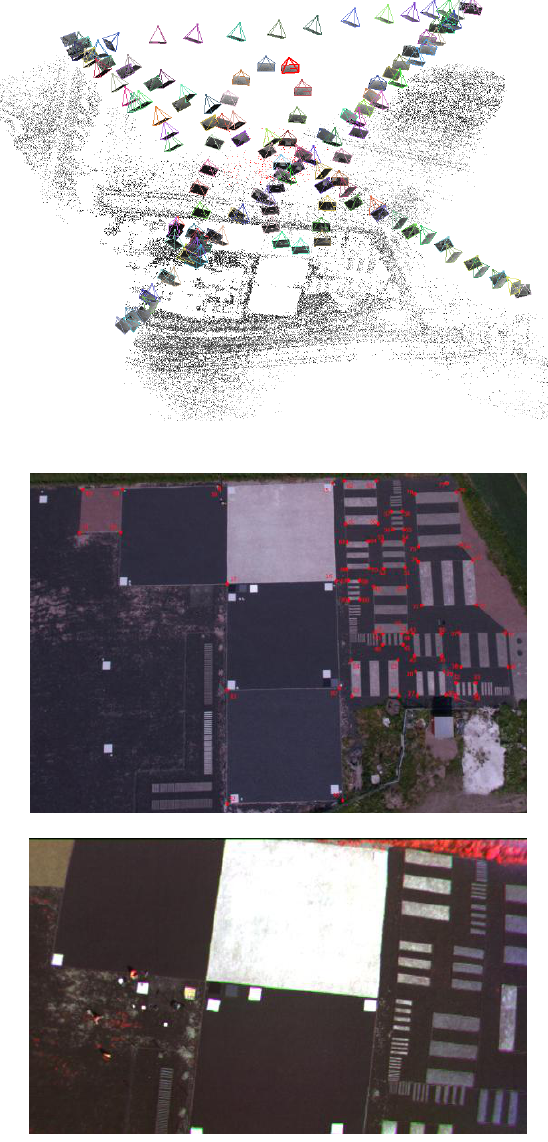
Figure 5. Traceable UAV campaign in Sjökulla remote sensing test field. From top: the image block with three vertical flight lines and two crossing oblique bi-directional flight lines; sample RGB image with ground control points; sample FPI image.